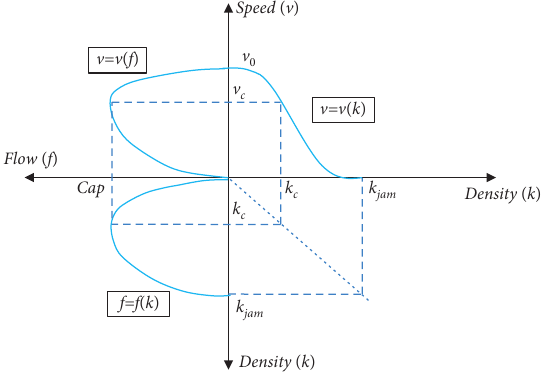
Figure 2: Fundamental diagram of traffic